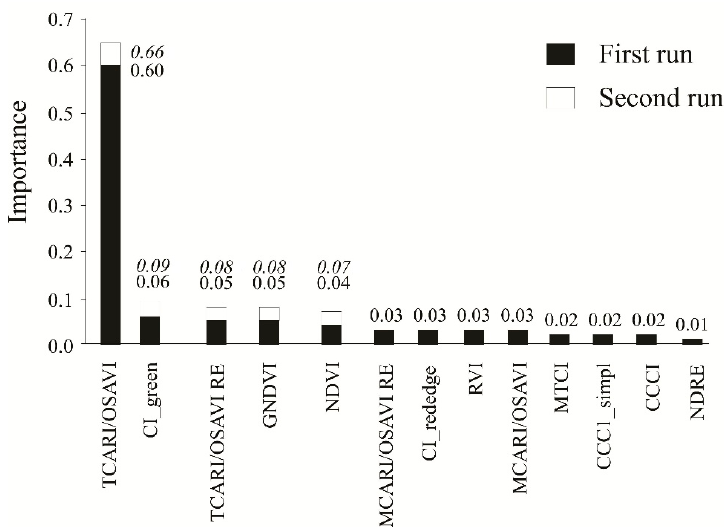
Figure 4. Implementation of two iterations of RF to explore the individual contribution of the explanatory variables according to their importance value to the estimation of Nt. The numbers in italics correspond to the importance value of the five most important variable in the second iteration.